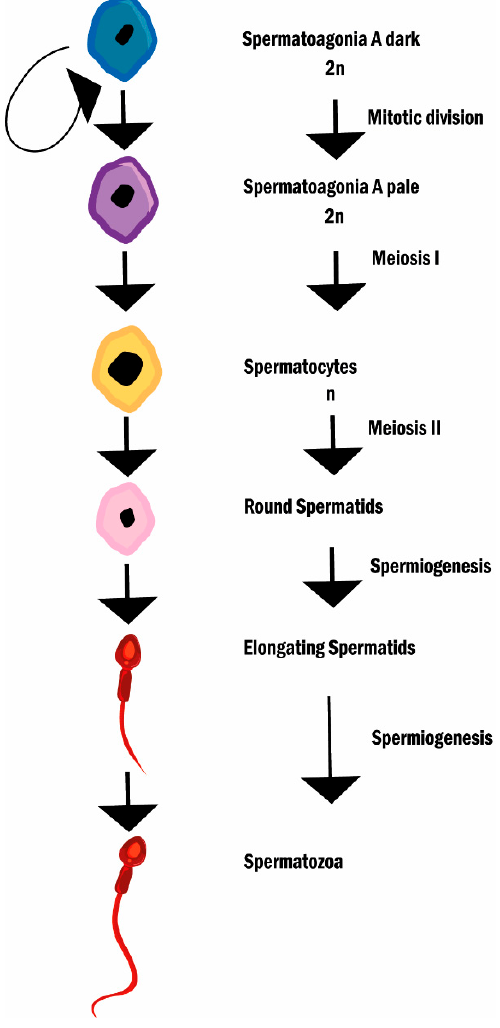
Figure 2. Spermatogenesis and spermiogenesis. The diagram describes the different stages of spermatogenesis and spermiogenesis.